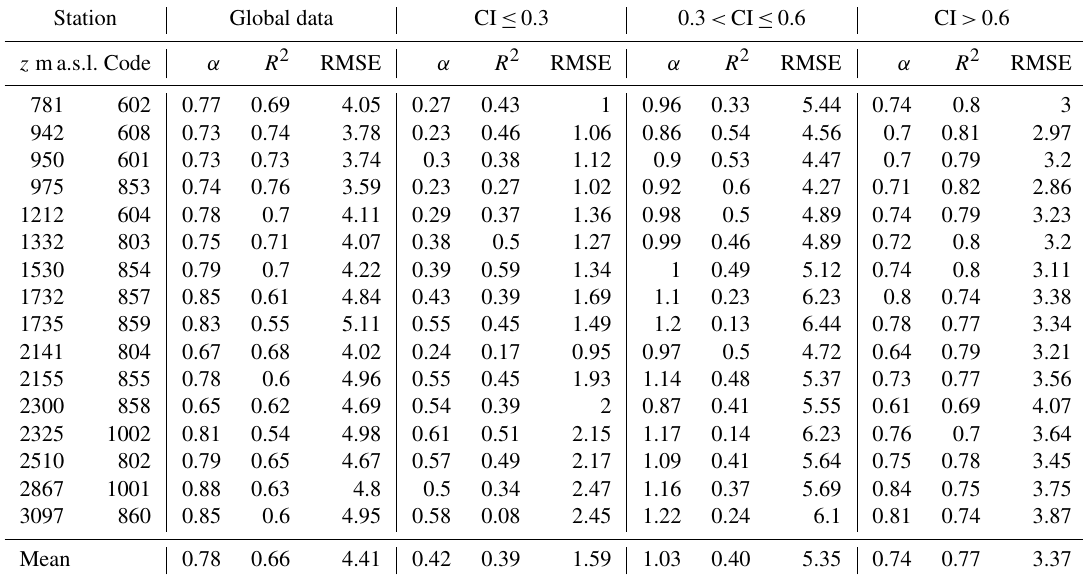
Table C1. Model performance with Solar Analyst: slope ( α ) and r 2 of the linear fit between daily predicted vs. observed R g and RMSE (MJm − 2 d − 1 ). Station Global data